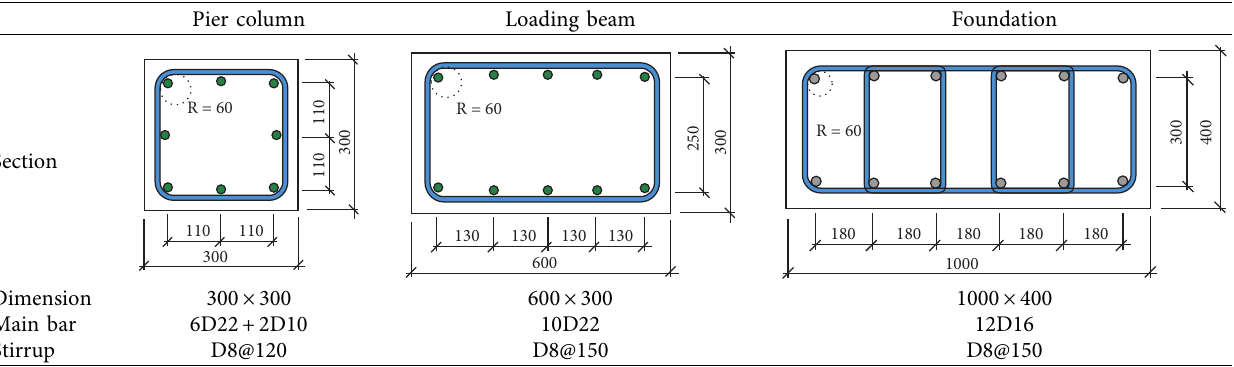
Table 2: Sectional dimension and reinforcement arrangement.